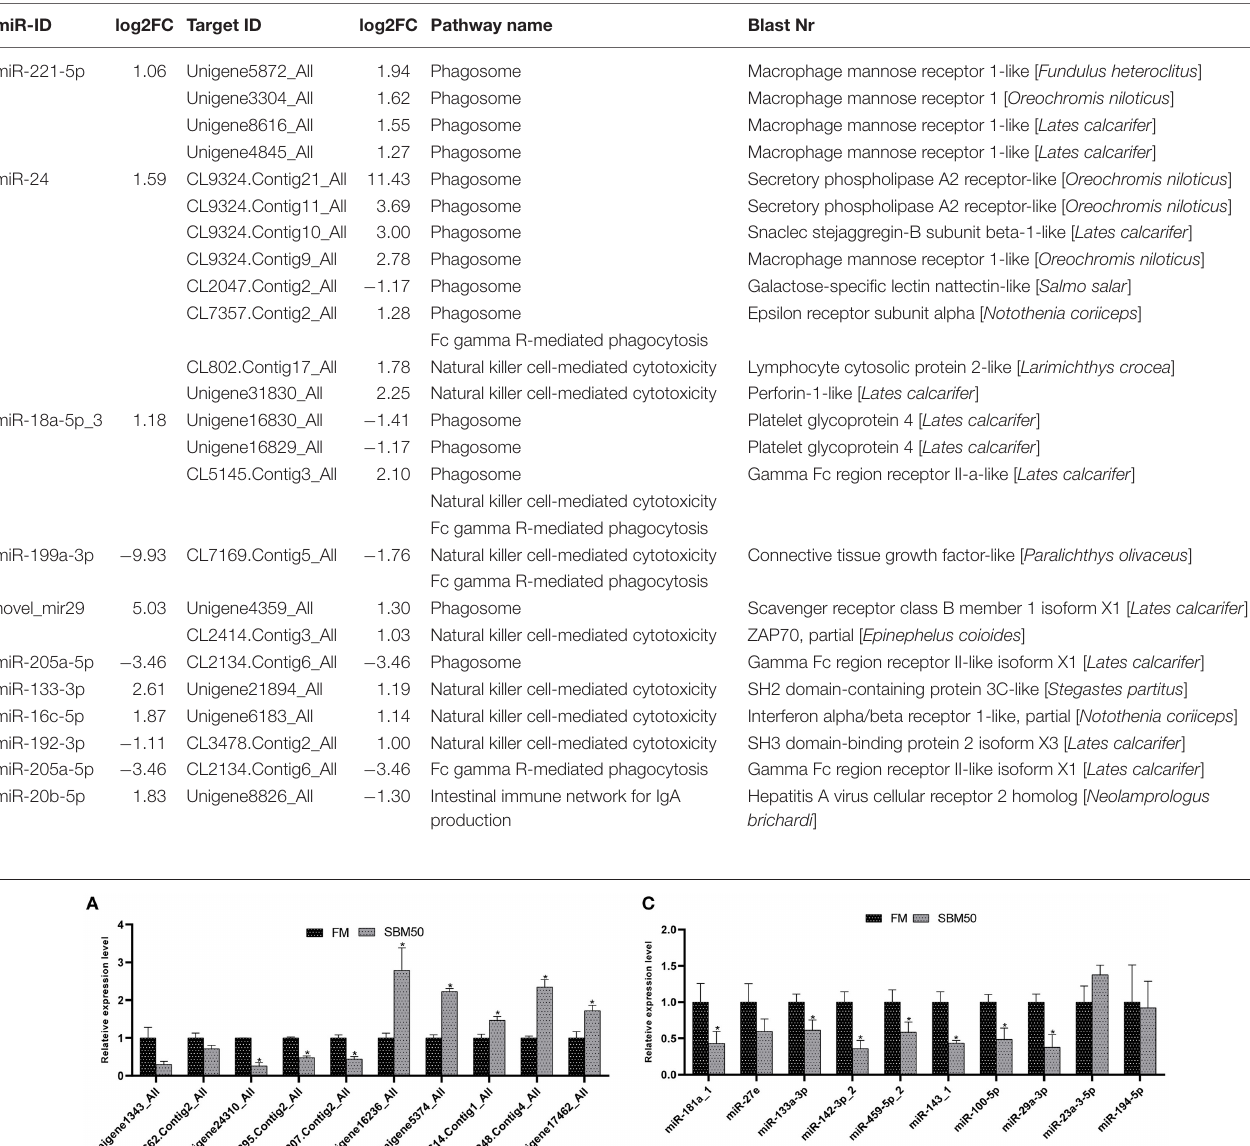
TABLE 5 | The miRNAs and their targets involved in the immune-related pathways. miR-ID